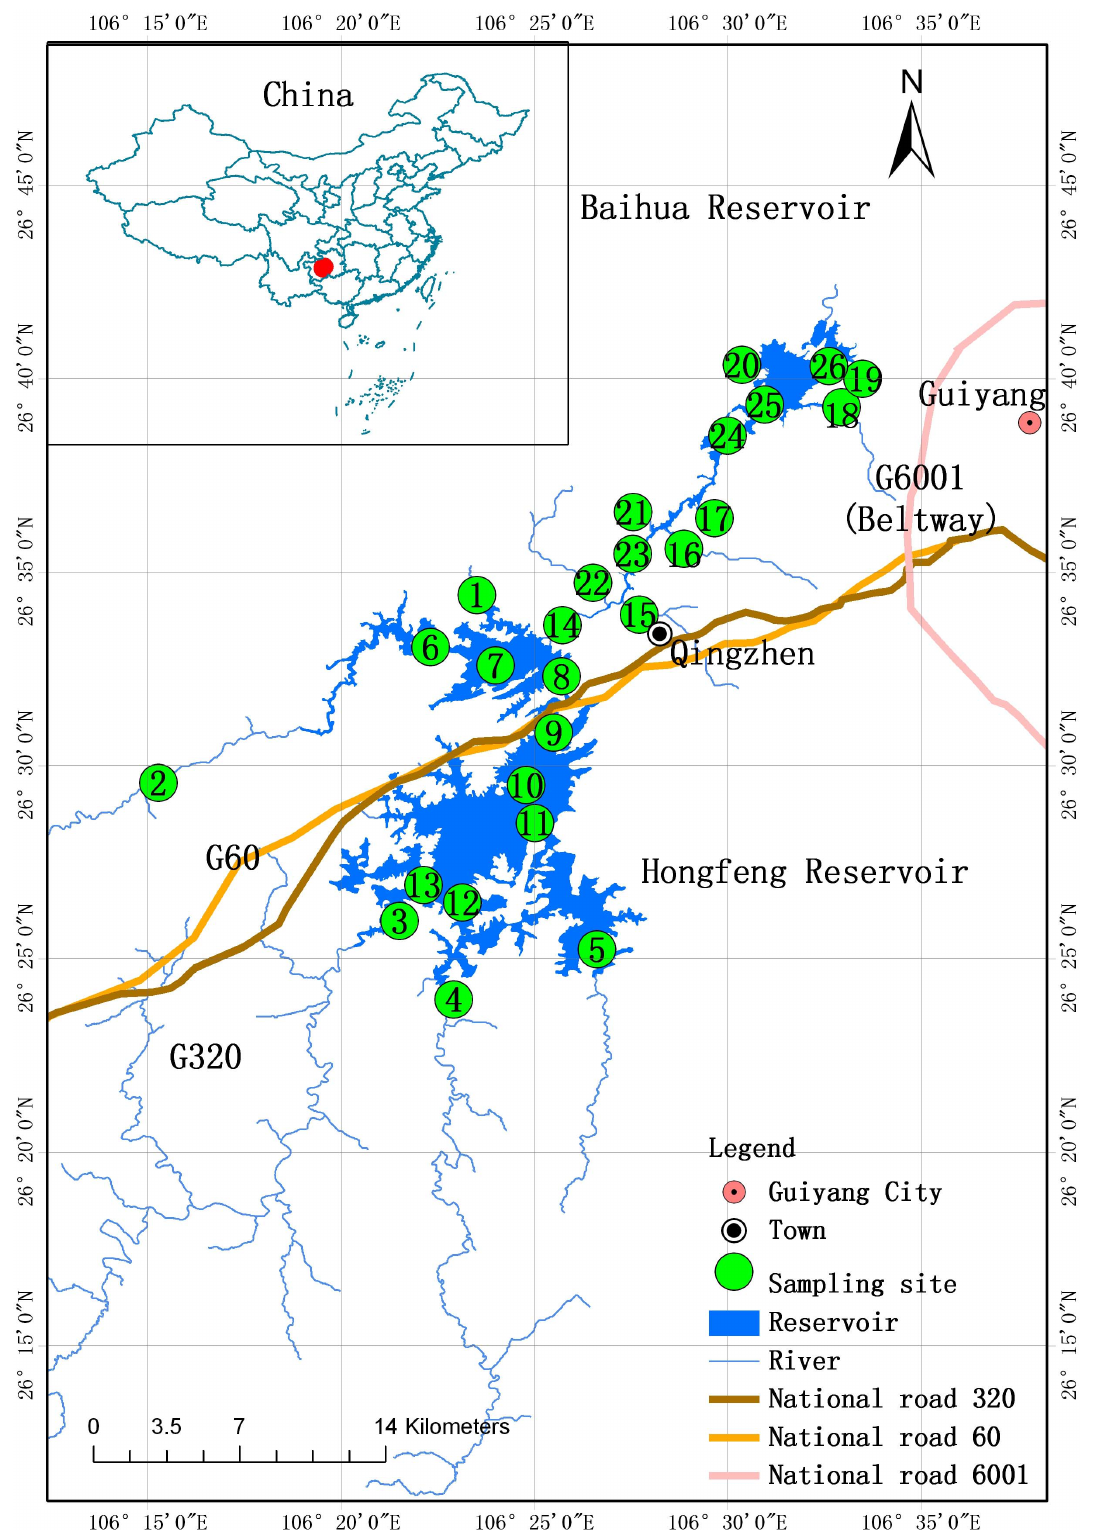
Figure 1. Map of Hongfeng and Baihua Reservoirs on the Yunnan-Guizhou Plateau, Southwest China. doi:10.1371/journal.pone.0102101.g001 measured using atomic fluorescence spectrometry. Quality assur-